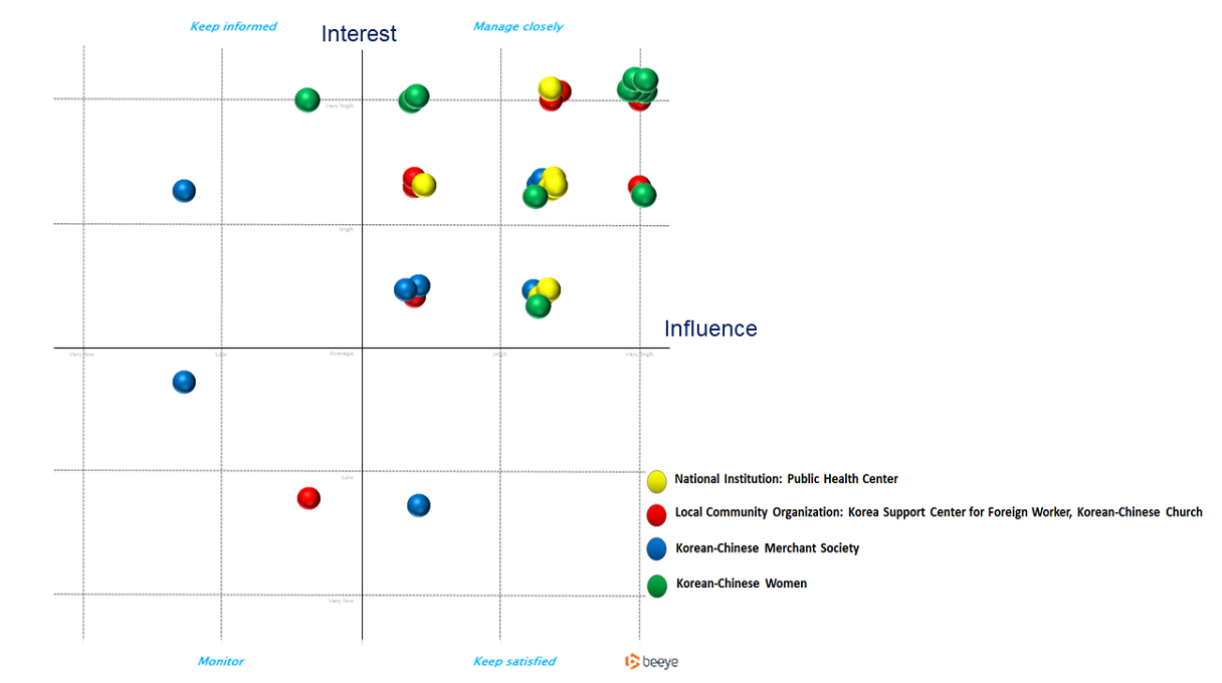
Figure 2. Stakeholder analysis: interest and